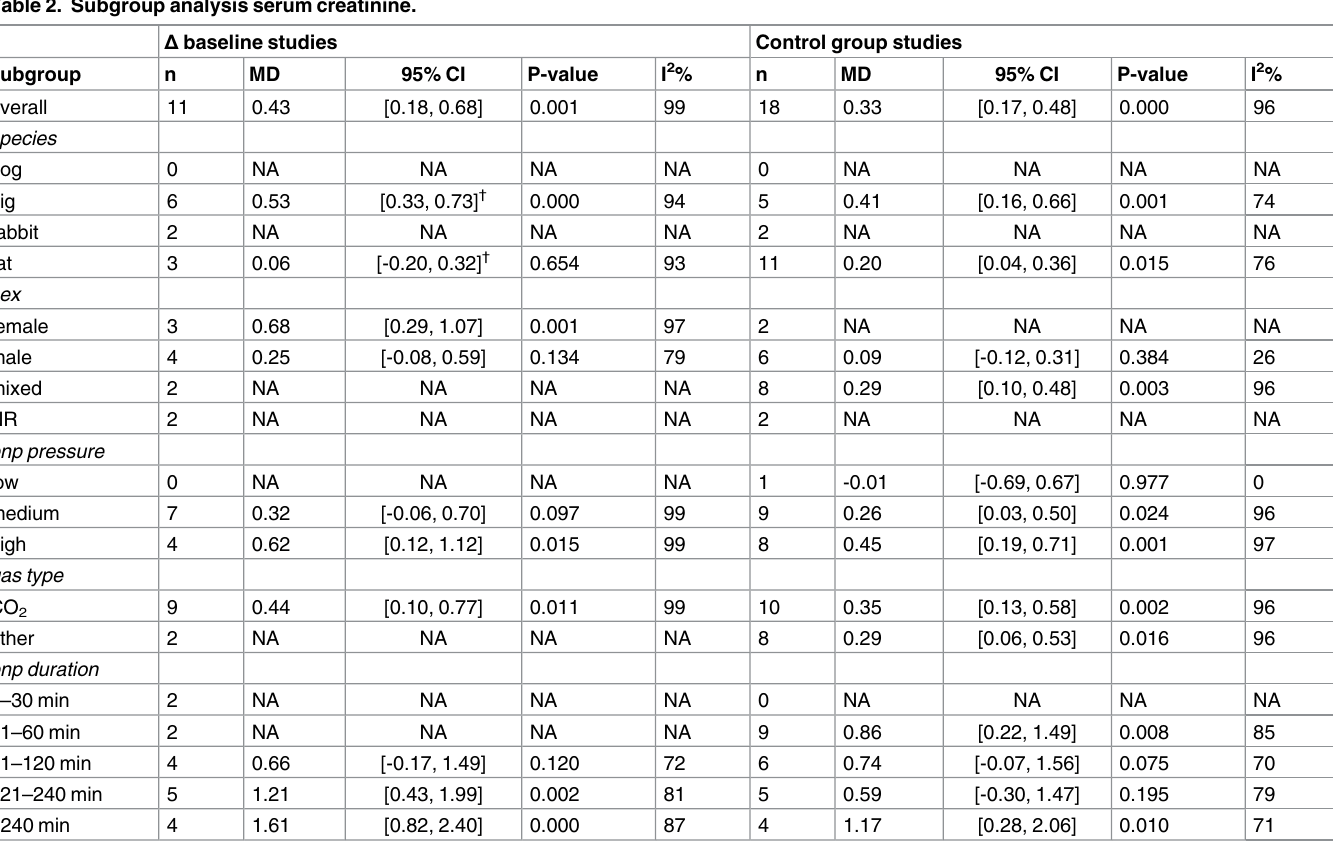
Table 2. Subgroup analysis serum